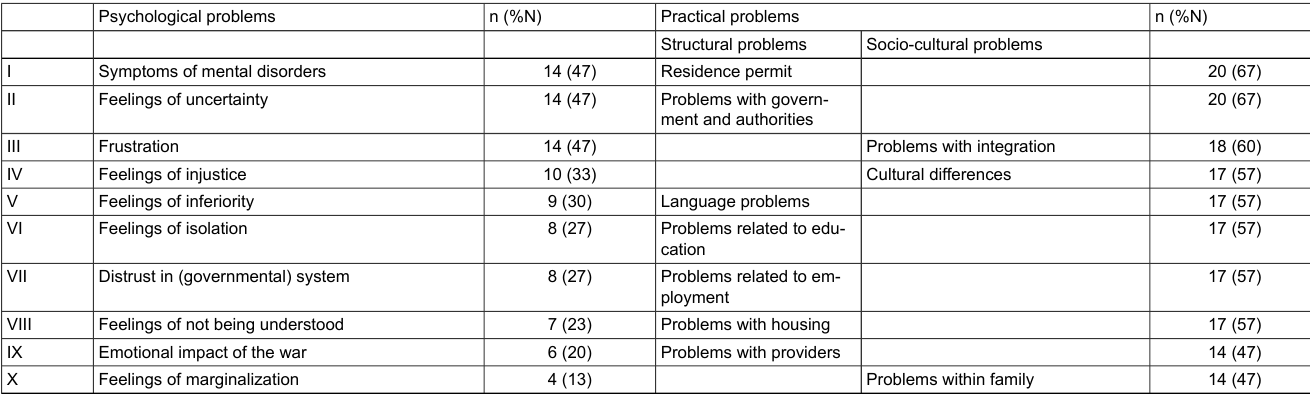
Table 2: Psychological and practical problems faced by Syrian refugees and asylum seekers in Switzerland (the 10 most common problems from each type). Psychological problems